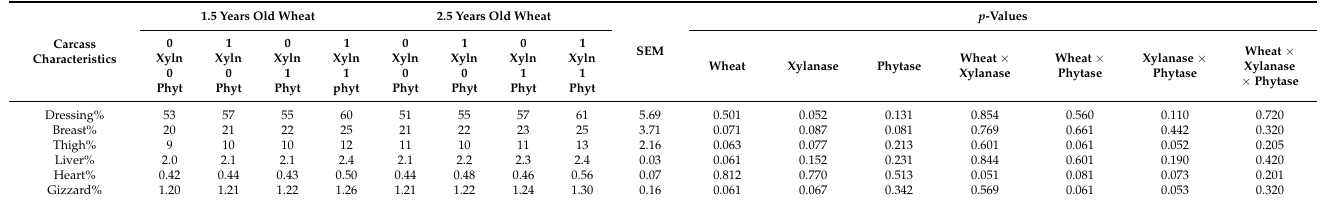
Table 6. Effect of stored wheat supplementation with and without xylanase and phytase on carcass characteristics of broiler birds at day